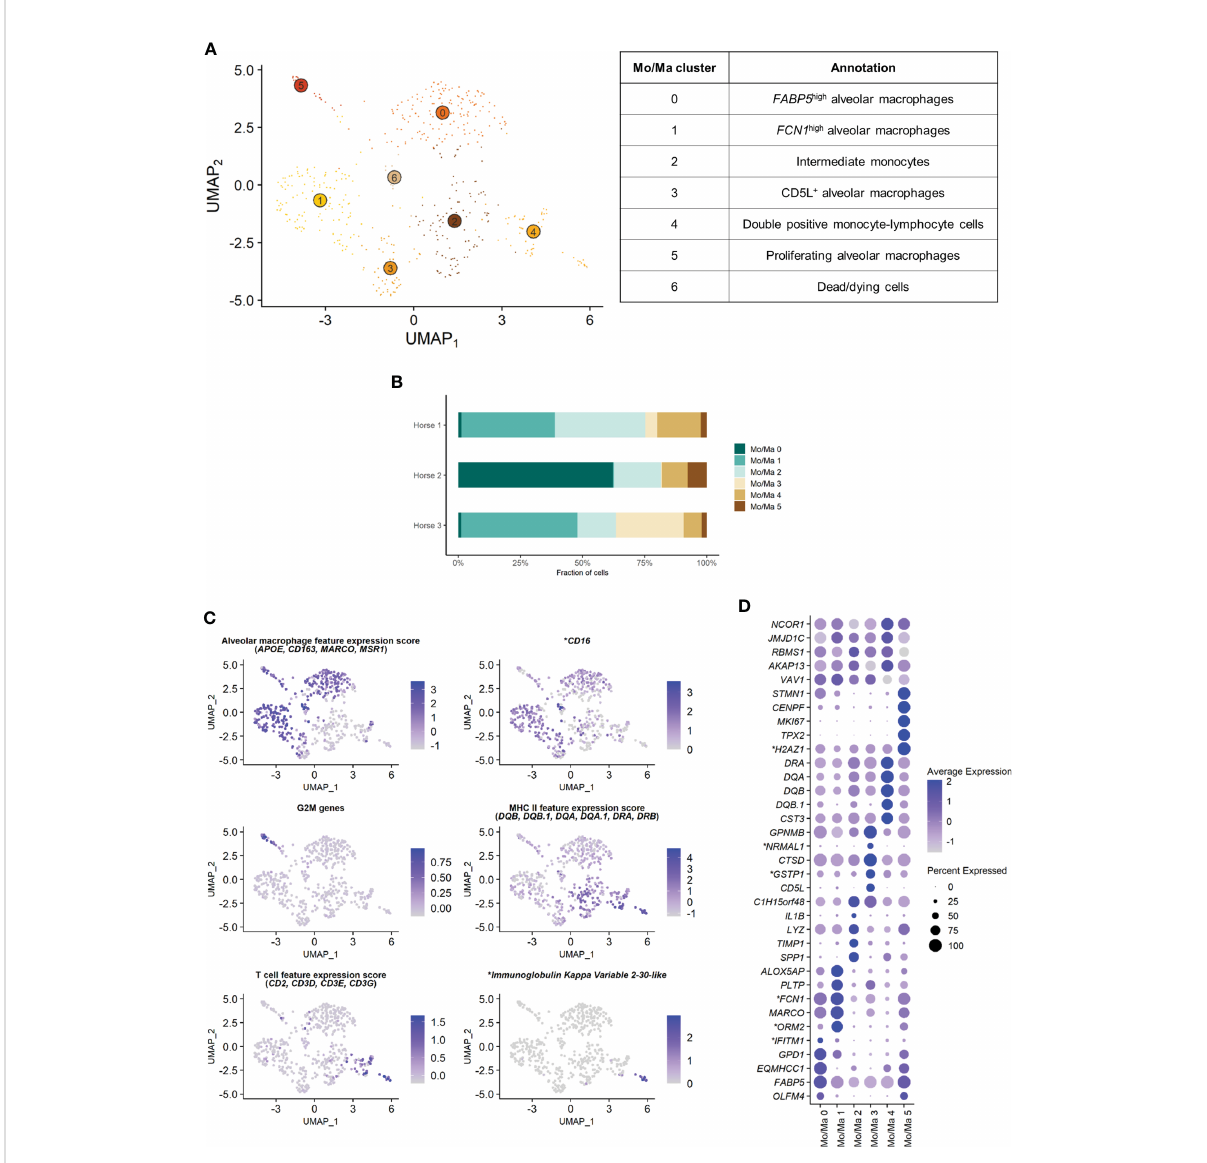
FIGURE 4 Independent analysis of the monocytes-macrophages (Mo/Ma) population (n=529 cells) (A) UMAP visualization of the 7 Mo/Ma clusters identi fi ed, with suggested cluster annotation. (B) Distribution of the Mo/Ma clusters for each horse, based on scRNA-seq analysis. (C) Gene expression patterns used for cell subtype assignment. *LOC100051526 annotated as CD16 (NCBI EqCab3.0 v103). (D) Dot plot of the 5 most upregulated genes in each cluster. Dot size is proportional to the percentage of cells expressing the gene. Dot color intensity represents average gene expression. Mo/Ma 6 (dead cells) is excluded. *LOC100146489 annotated as H2A.Z variant histone 1 (H2AZ1), LOC100067916 as NmrA like redox sensor 1 (NRMAL1), LOC100059533 as glutathione S-transferase pi 1 (GSTP1), LOC100069029 as fi colin 1 (FCN1), LOC100050560 as interferon induced transmembrane protein 1 (IFITM1) and LOC100050100 as orosomucoid 2 (ORM2) (NCBI EqCab3.0